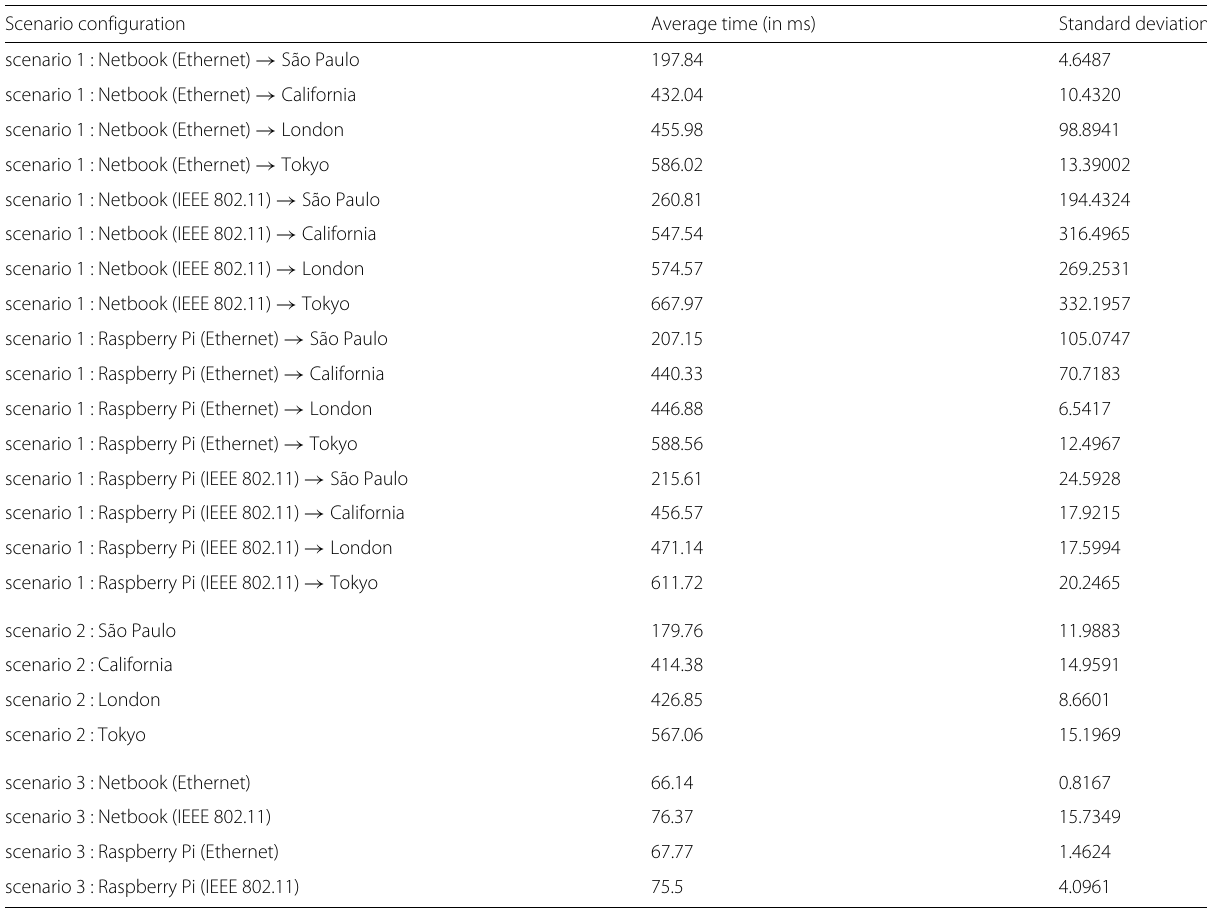
Table 6 Results from prototype